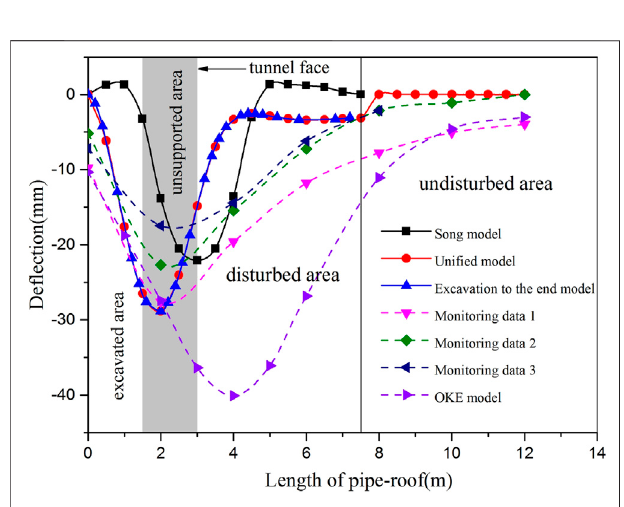
FIGURE 8 | The de fl ection of the steel pipe in the